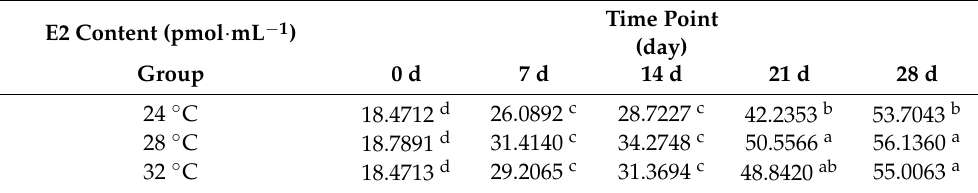
Table 4. Changes of serum E2 content in Nile tilapia serum after different temperature treatments.